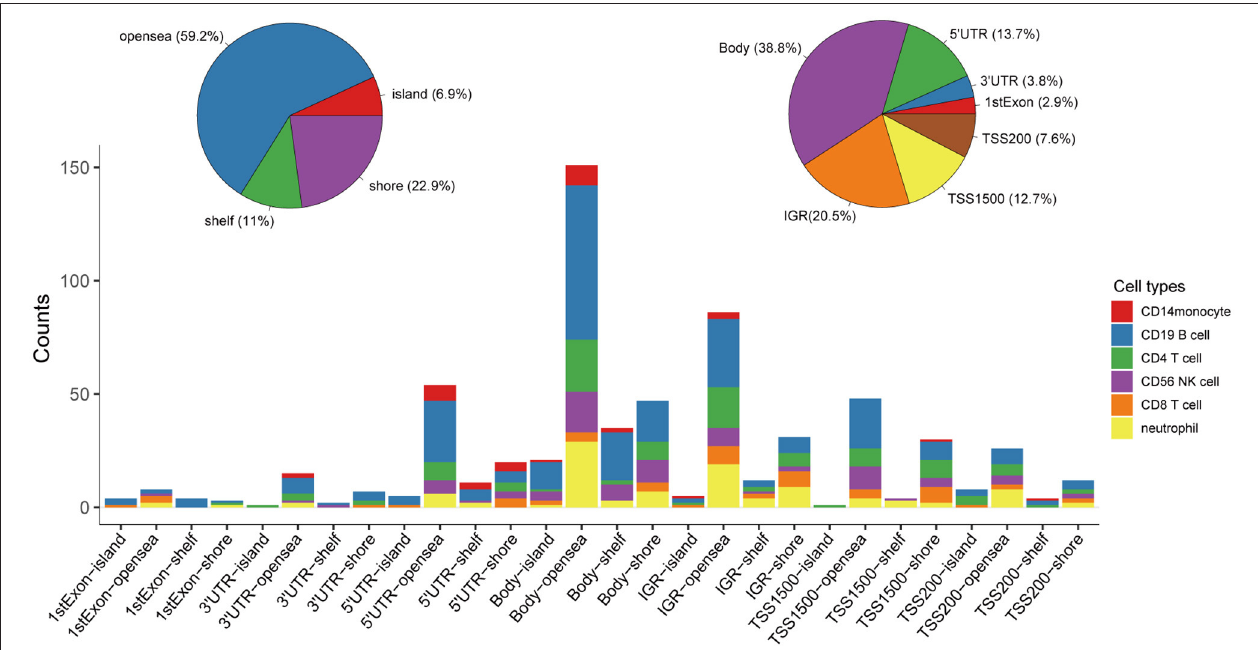
FIGURE 3 | Distributions corresponding to the gene region and CpG island of the IC-SHMSs. Most of these IC-SHMSs were located in the region of gene body and CpG island opensea. IGR, Intergenic region; TSS, transcription start site; UTR, untranslated